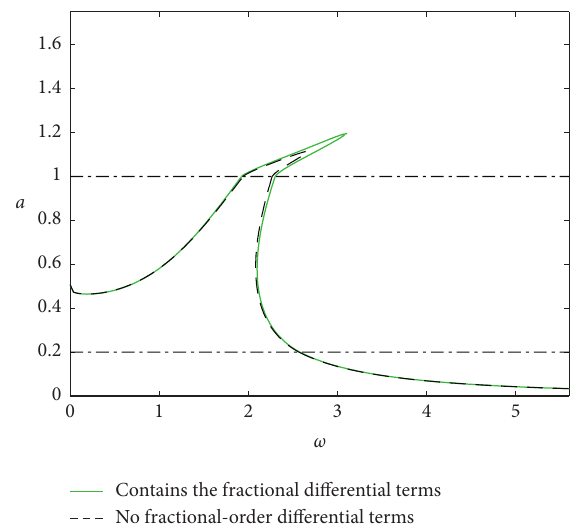
Figure 3: Comparison diagram of amplitude frequency response curves of systems with and without time delay and its local en- largement